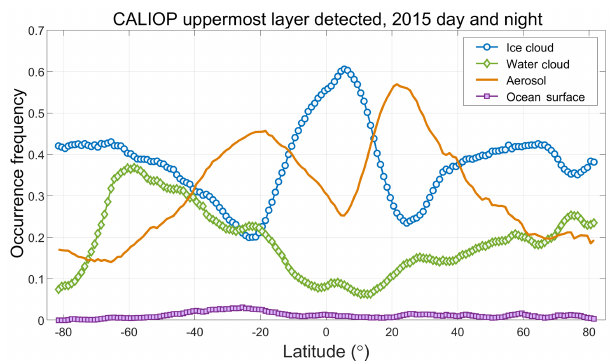
Figure 27. Occurrence frequencies for the uppermost feature de- tected at 5km horizontal resolution as a function of latitude for all CALIOP measurements acquired during